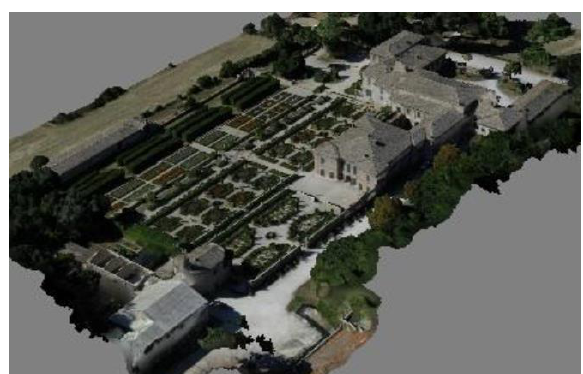
Figure 5. 3D textured